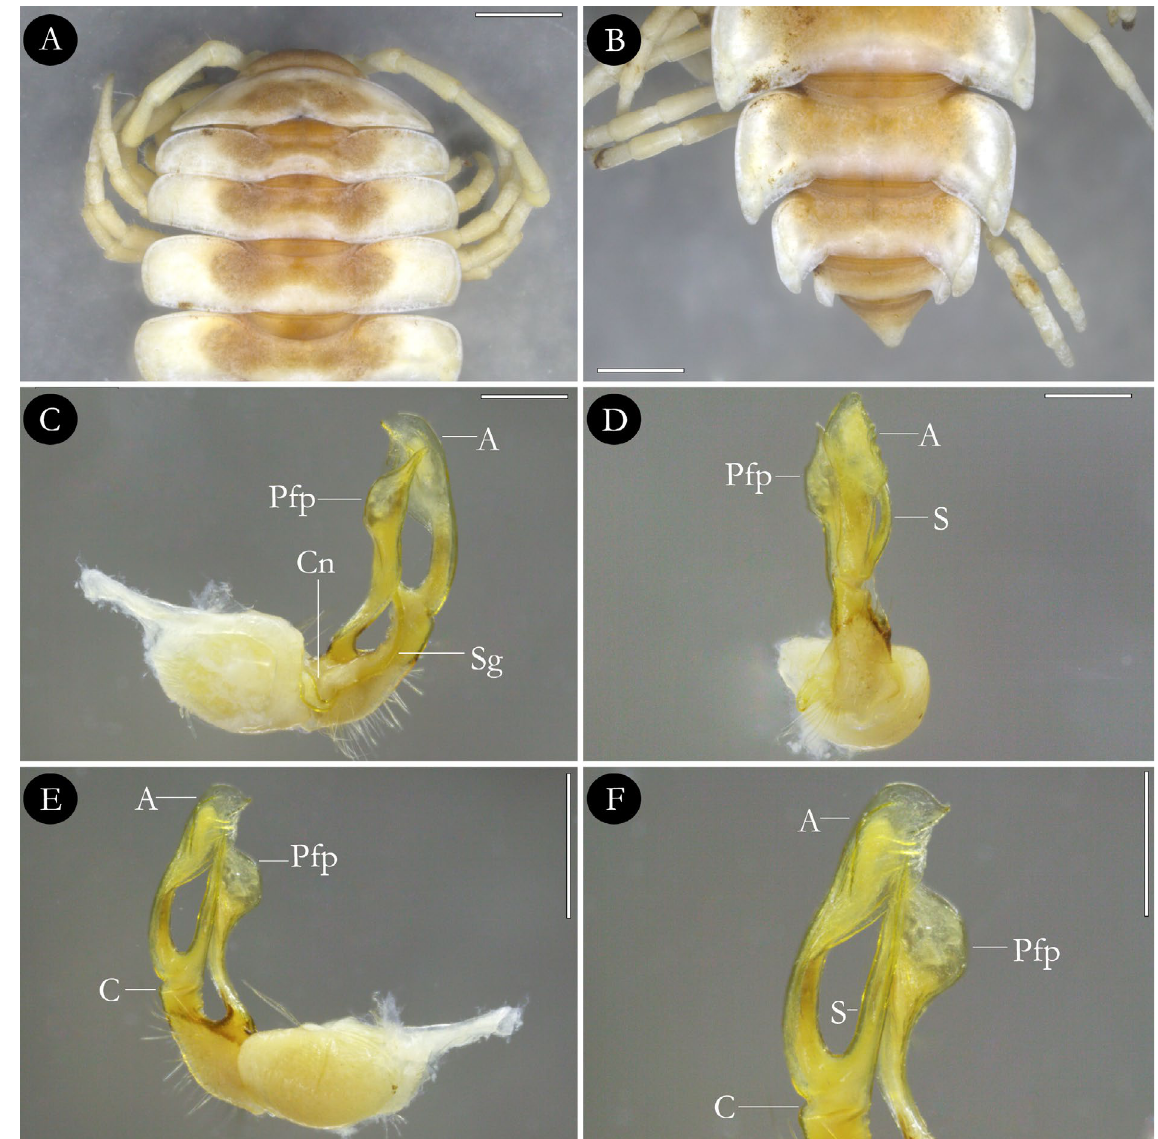
Fig. 2. Atlantodesmus sierwaldae sp. nov., holotype, ♂ (IBSP 180). A . Anterior region in dorsal view. B . Posterior region in dorsal view. C–F . Left gonopod. C . Mesal view. D . Ventral view. E . Ectal view. F . Detail of the distal portion in ectal view. Scale bars: A–B = 2 mm; C–D = 250 µm. E–F = 500